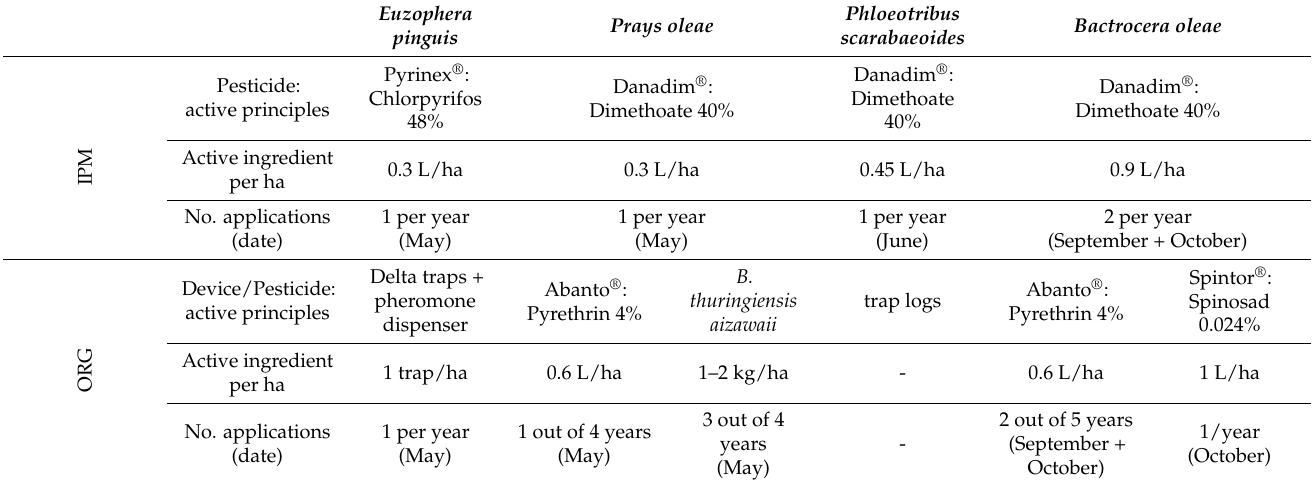
Table 1. Products applied in the control of the main pests and the annual application regime in both olive groves (IPM and